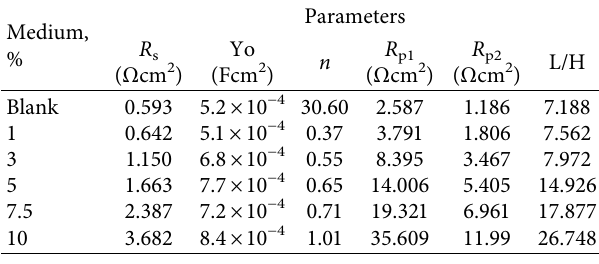
Figure 4: Electrochemical equivalent circuit simulated for steel alloy 4130 sample engrossed in 3.5 wt.% NaCl electrolyte and diverse loads of LI. Table 3: The electrochemical impedance parameters of steel alloy 4130 sample occupied in 3.5 wt.% NaCl solution with diverse loads of LI.